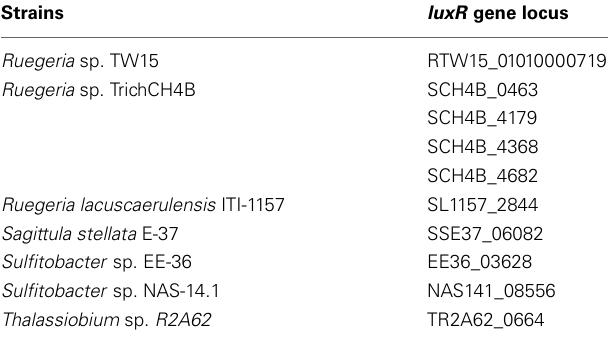
Table A2 | Putative orphan LuxR encoding genes that do not have an adjacent luxI on the